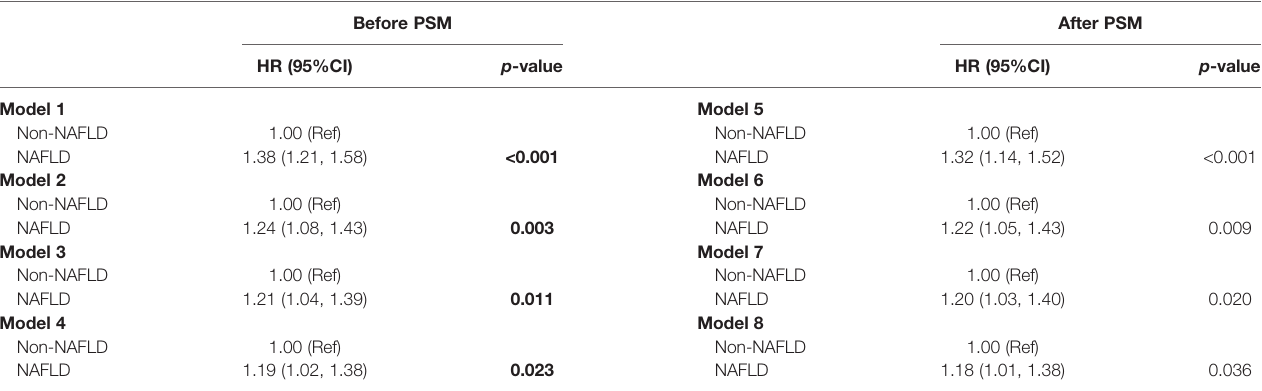
TABLE 2 | Association between non-alcoholic fatty liver status at baseline and risk of aortic calci fi cation a . Before